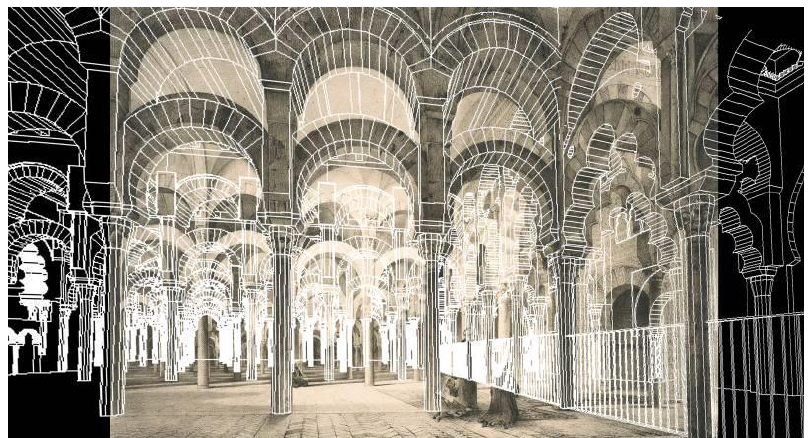
Figure 22. Girault de Prangey (1839). Digital model overlapping the mihrab side and the forest of columns. Source: Own production.